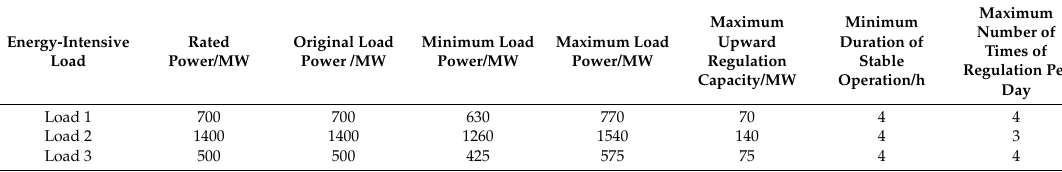
Table 2. Parameters of energy-intensive loads.